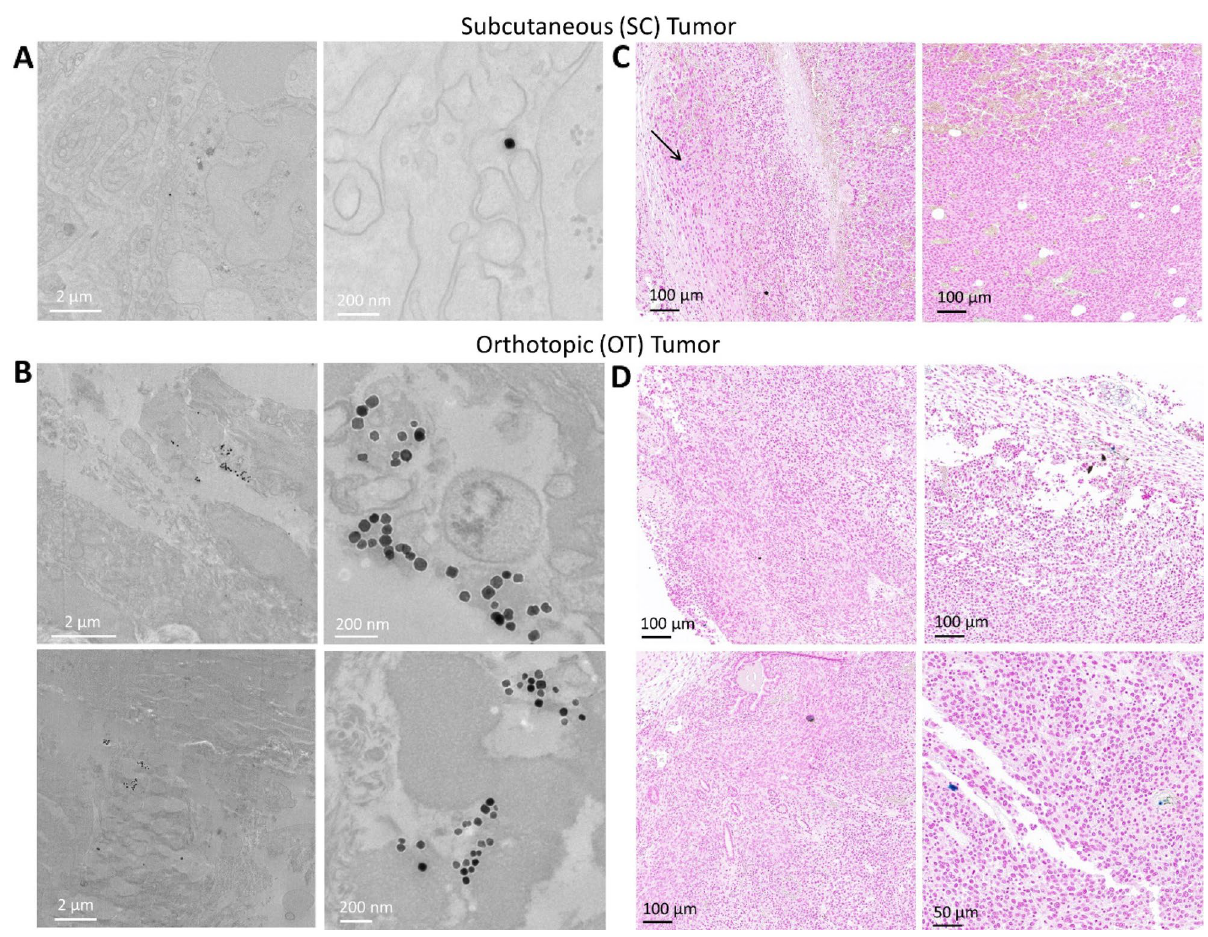
Figure 5. Tumor imaging after magnetosome intravenous administration and magnetic targeting. ( A ) and ( B ) Transmission electron microscope imaging of SC and OT tumors, respectively. ( C ) and ( D ) Histological Prussian Blue tissue staining in SC and OT tumors,